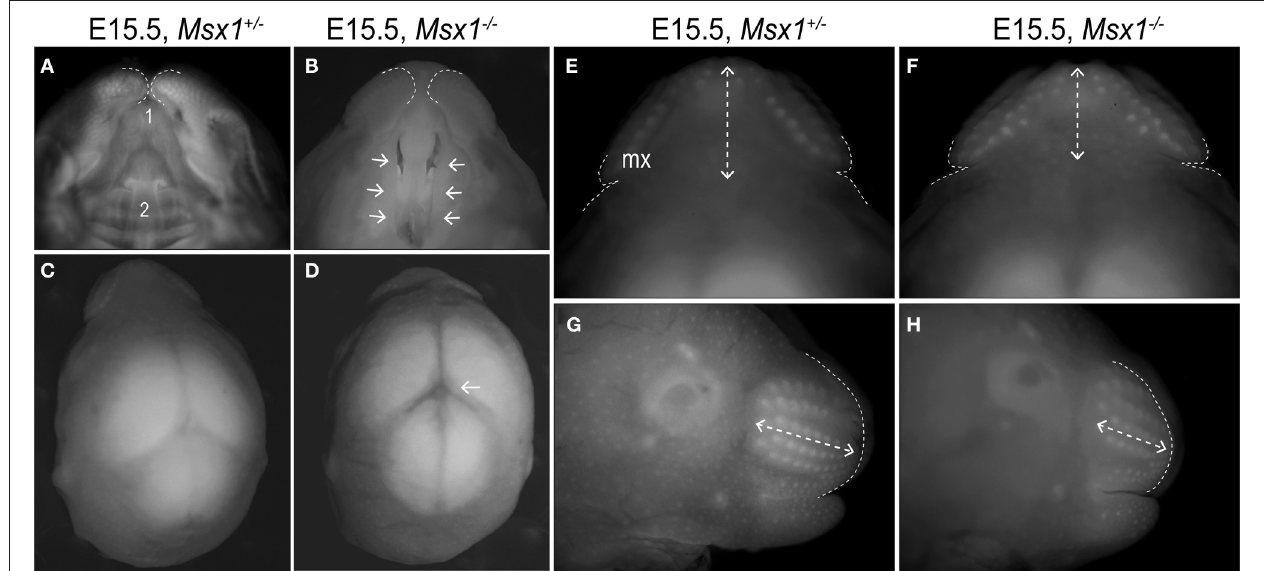
of Msx1 + / − and Msx1 − / − embryos; dashed lines indicates width of the rostrum (Maxillary width in Table 1 ). Dashed arrows indicate the length of the rostrum (maxillary length in Table 1 ). (G and H) Lateral view of Msx1 + / − and Msx1 − / − embryos. Dashed lines indicate outline of the maxillary prominence; dashed arrows indicate length of the rostrum. Mx,